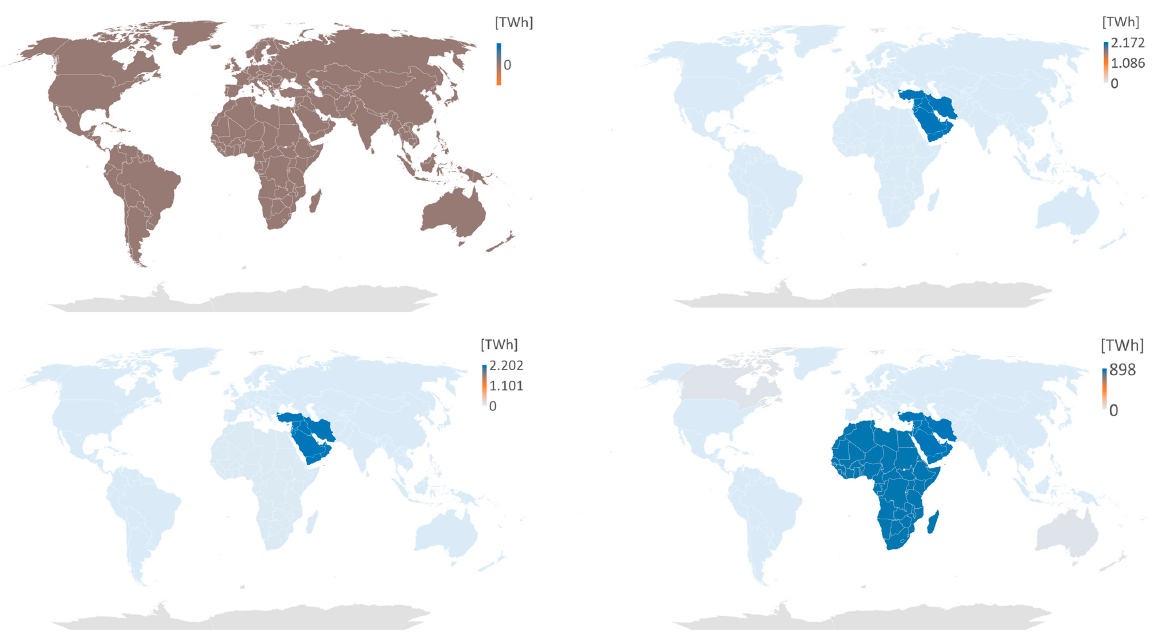
Figure 8. Hydrogen Export along all scenarios in 2100. BAU is top left, 1_5D is top right, SoS1 is bottom left and SoS2 is bottom right.